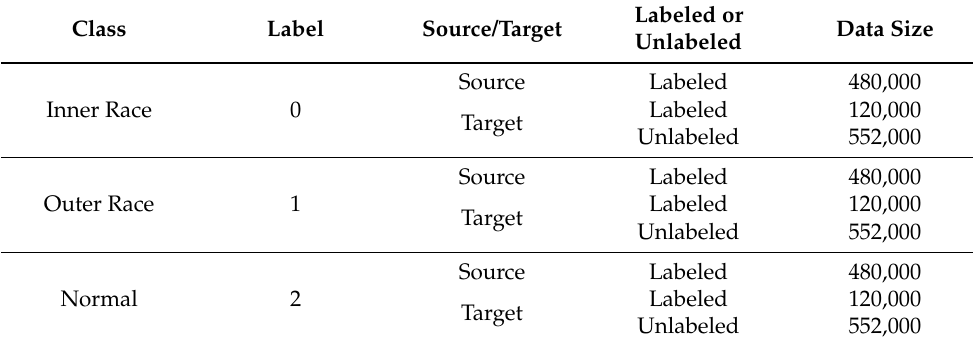
Table 2. Data selection of three classes.